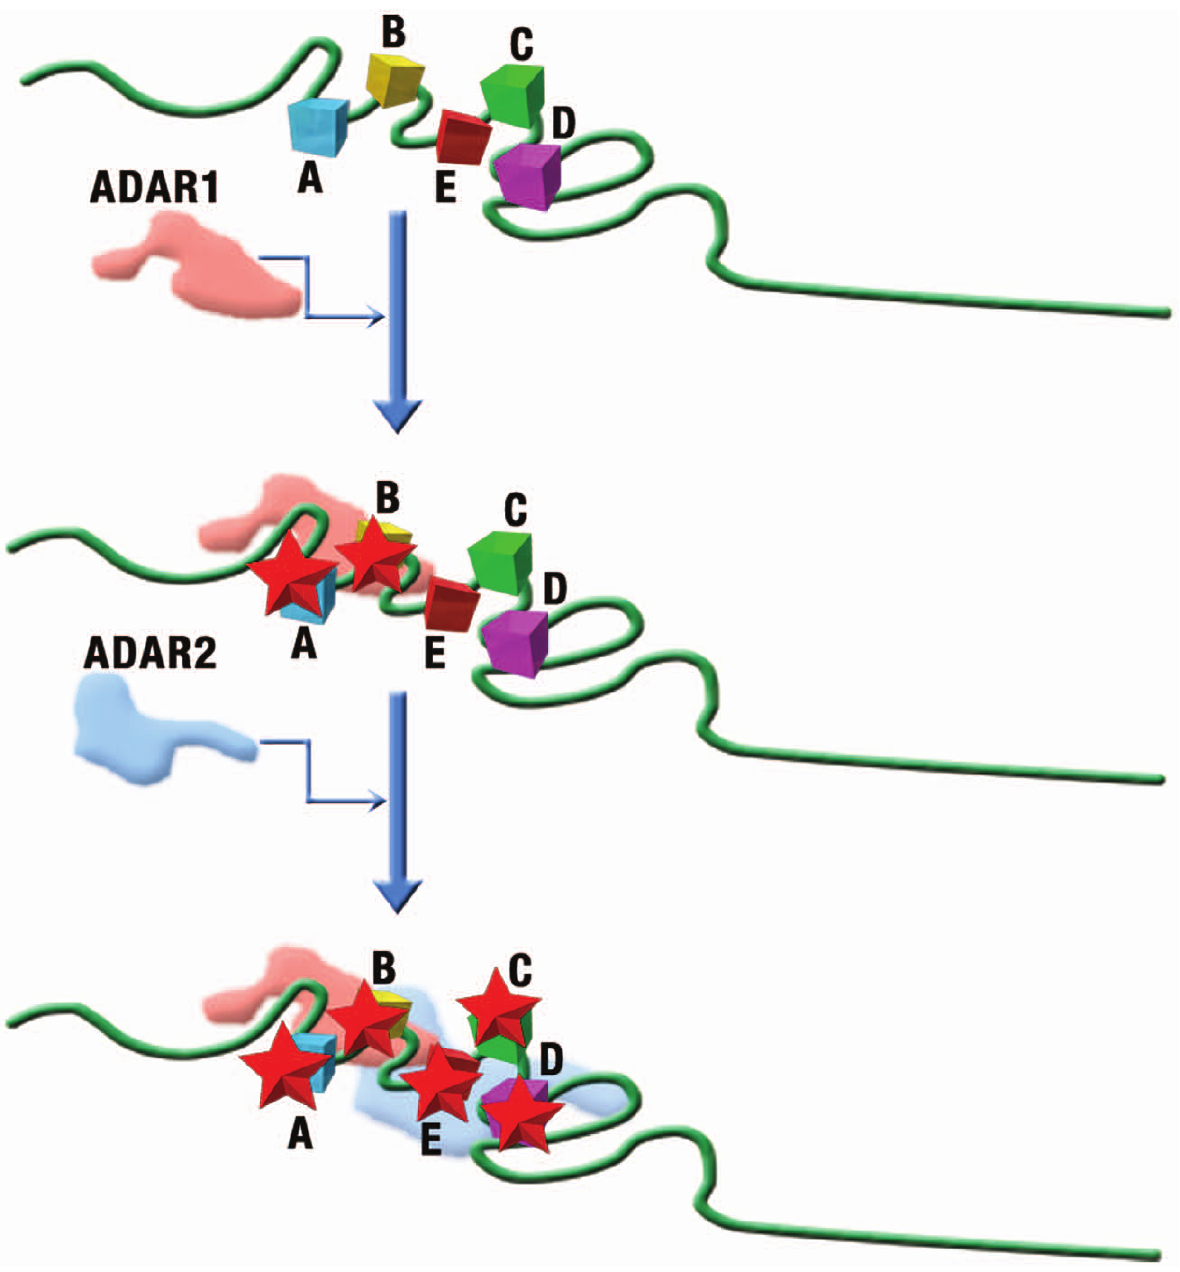
Figure 6. A hypothetical mechanistic model of concerted action of ADAR1 and ADAR2 in 5-HT 2C R mRNA editing. The squares denote the 5 distinct editing sites and the stars denote editing. The figure is not to scale.